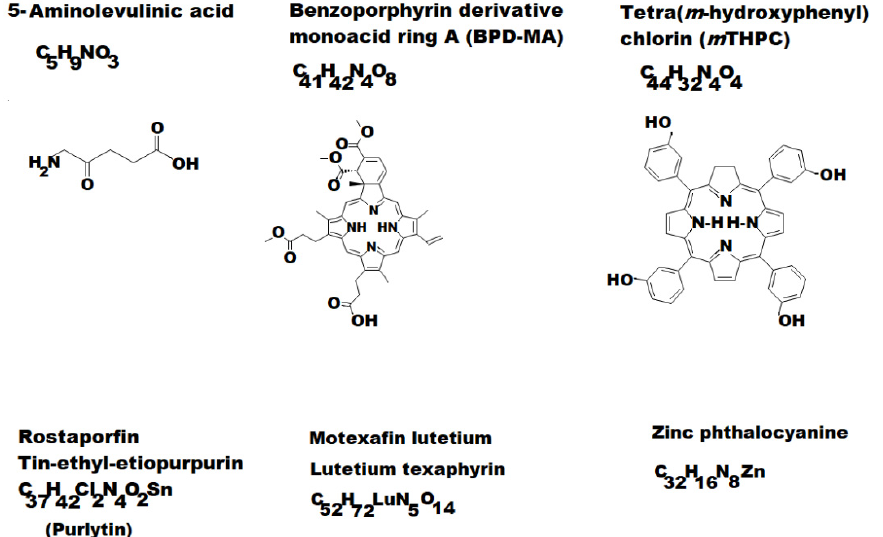
Figure 2. Some examples of second-generation photosensitizers (PSs).